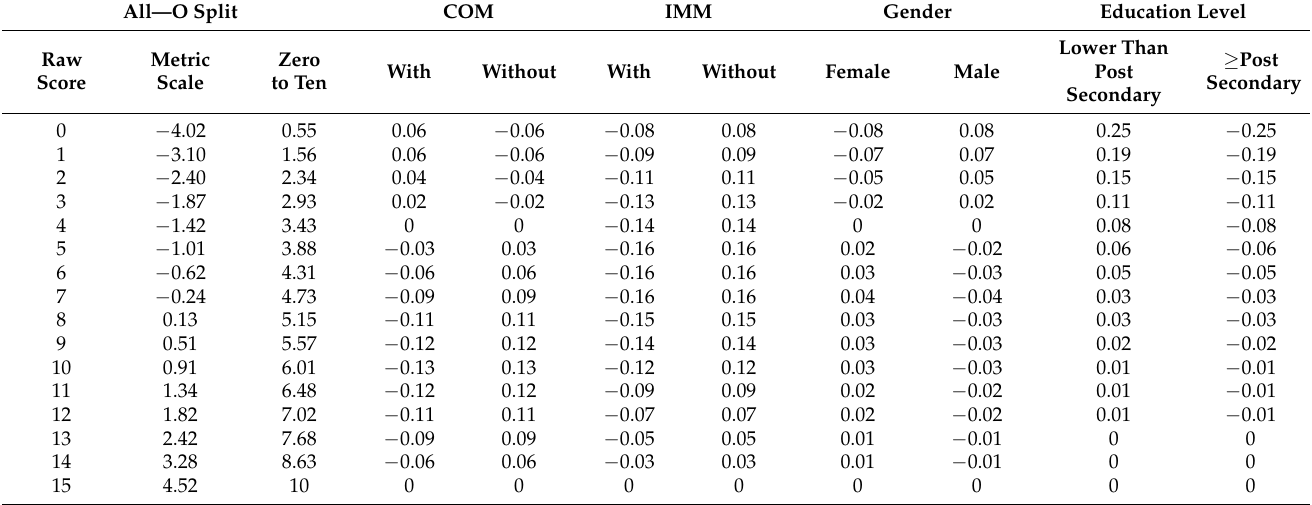
Table 4. Transformations of raw scores into metric scales (logit scales and from zero to ten). ‘COM’ refers to persons with comorbidities; ‘IMM’ refers to persons with immunosuppressive medication; the numbers below COM, IMM and gender represent the difference between the metric scales for these subgroups, e.g., persons with and without comorbidities, and represent a possibility to adjust the metric scores for a better comparability of persons with different personal